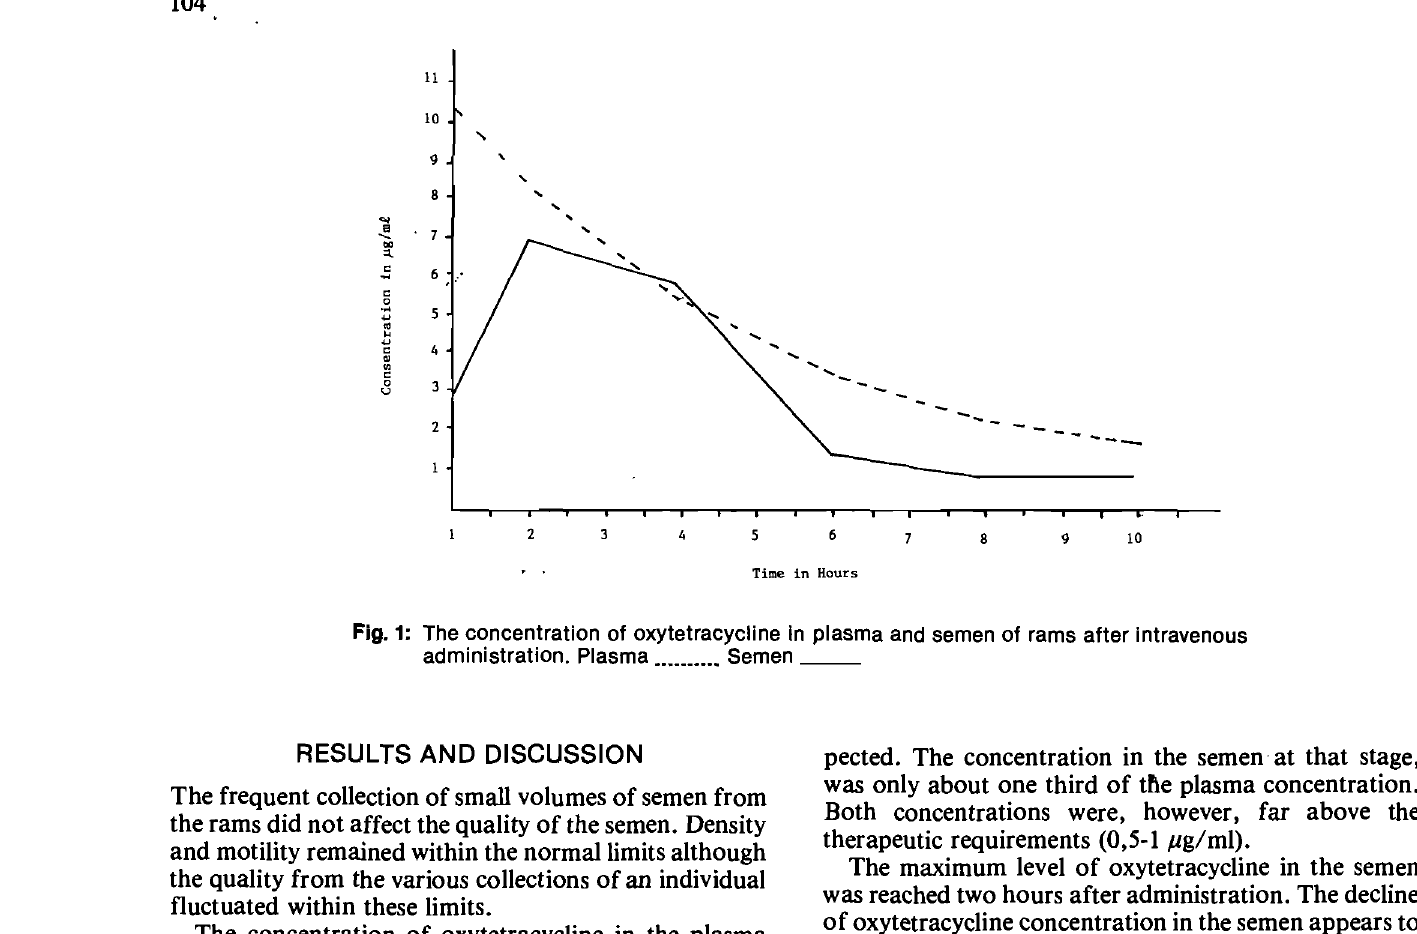
Table 1. The concentration of oxytetracycline in plasma and ram's semen after intravenous administration. = (Mean ± standard deviation (S.D.); n